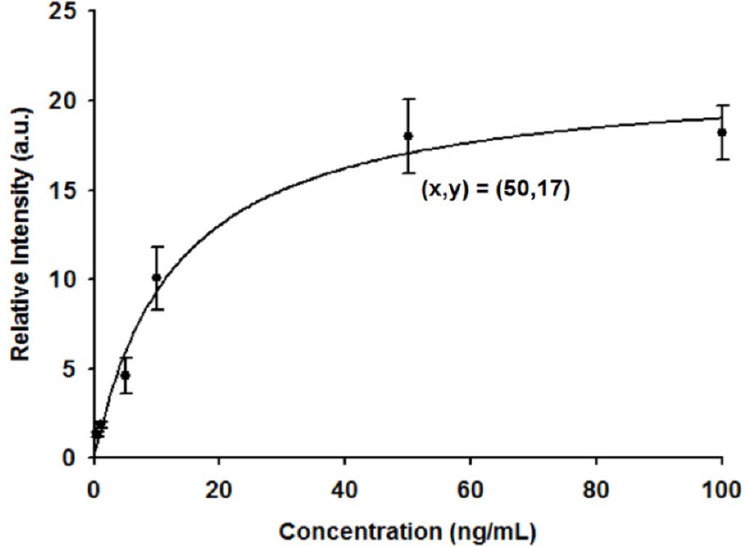
Figure 1. Calibration curve of SPR intensity against the concentrations of fetal fibronectin (fFN) (0.5, 1, 5, 10, 50, and 100 ng/mL), with a correlation coefficient (R 2 ) of 0.985. The SPR intensity corresponding to the fFN ELISA critical concentration of 50 ng/mL was 17